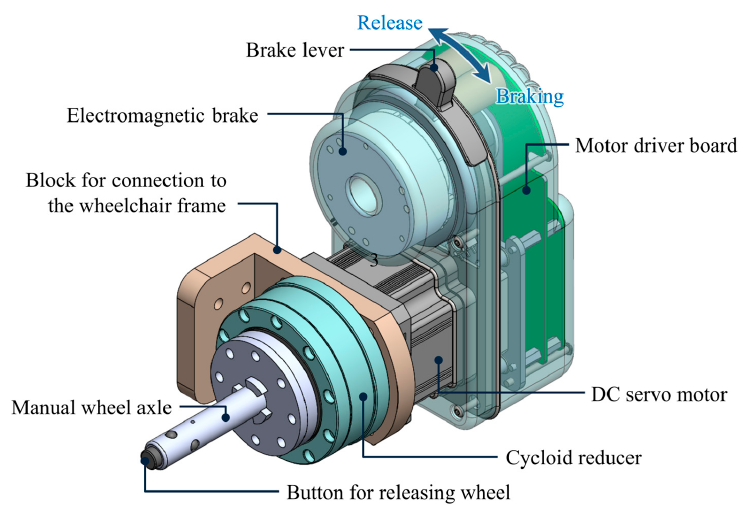
Figure 8. Power unit con fi guration.